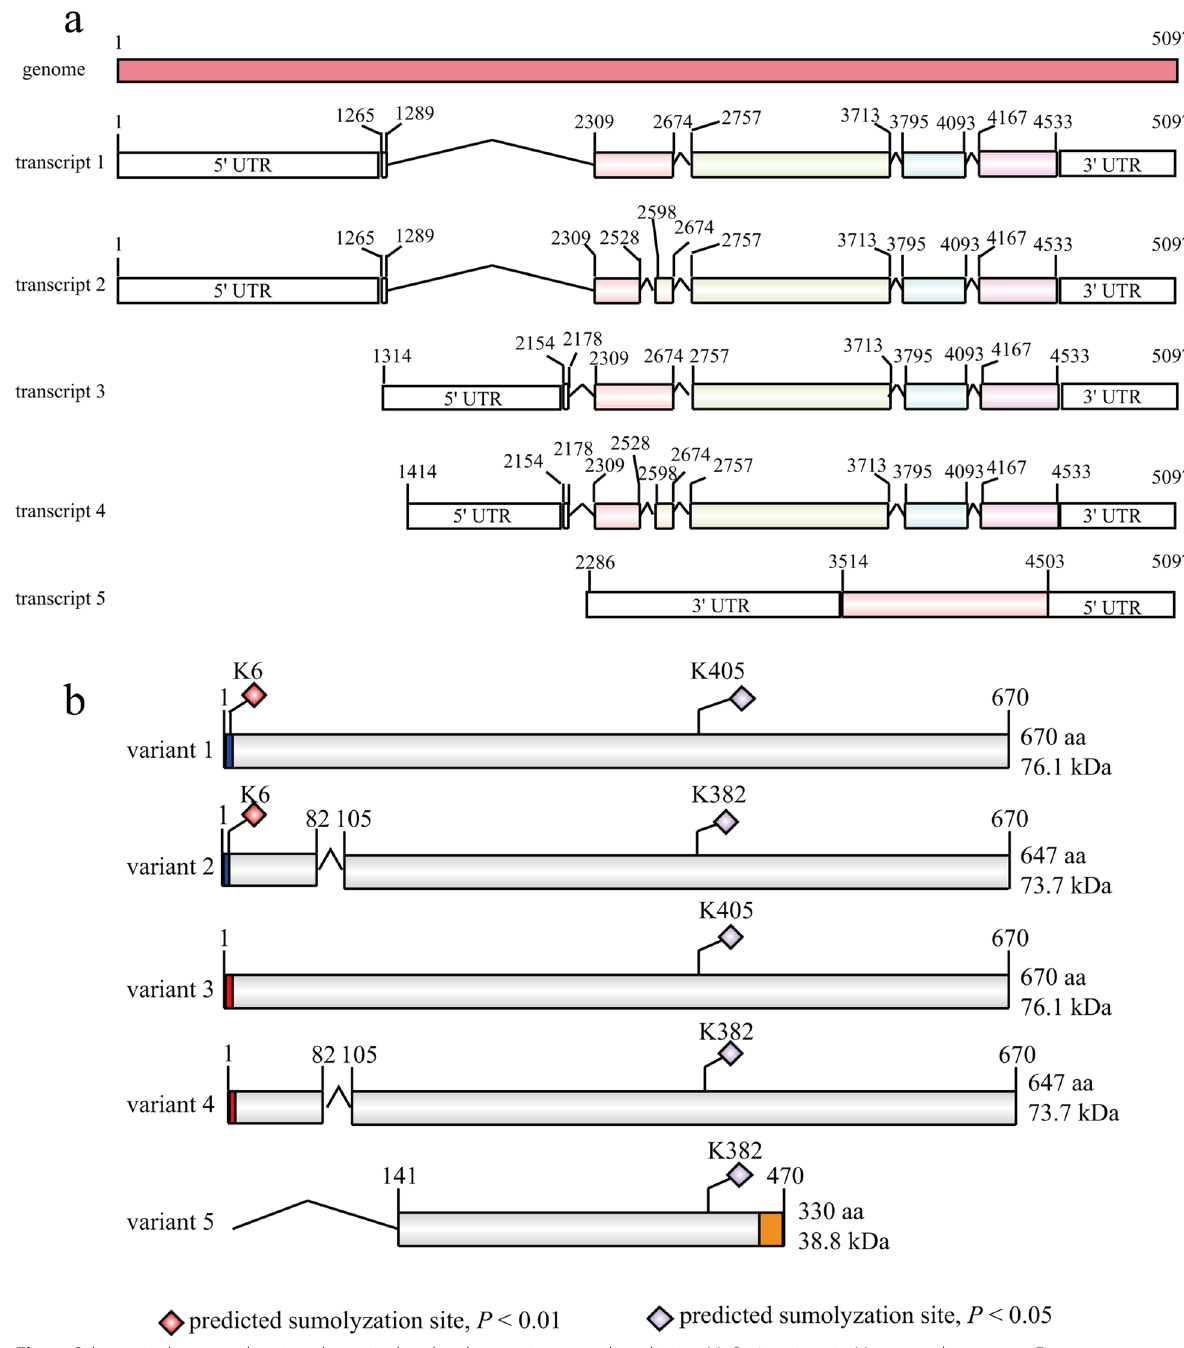
Fig. 7 Schematic diagrams showing alternatively spliced transcripts encoding distinct MoB56 variants in Magnaporthe oryzae . a Five transcripts of MoB56 identified in P131 mycelia. The RNA‑seq data previously reported by Li et al. (2021) were used to identify the transcripts originating from alternative splicing of MoB56. Intron retention events were found in transcript 1 and transcript 3. Curved lines indicate introns spliced from the transcripts, and exons are represented by color‑filed boxes with numbers that indicate start and end positions. The 5’ and 3’ untranslated regions are represented with blank boxes. b Deduced variants of MoB56 from transcripts in a . Colored boxes indicate the amino acid sequences different between the variants. Curved lines with numbers indicate the amino acid sequences absent from the variant as compared with others. Diamonds with numbers indicate potential sites of